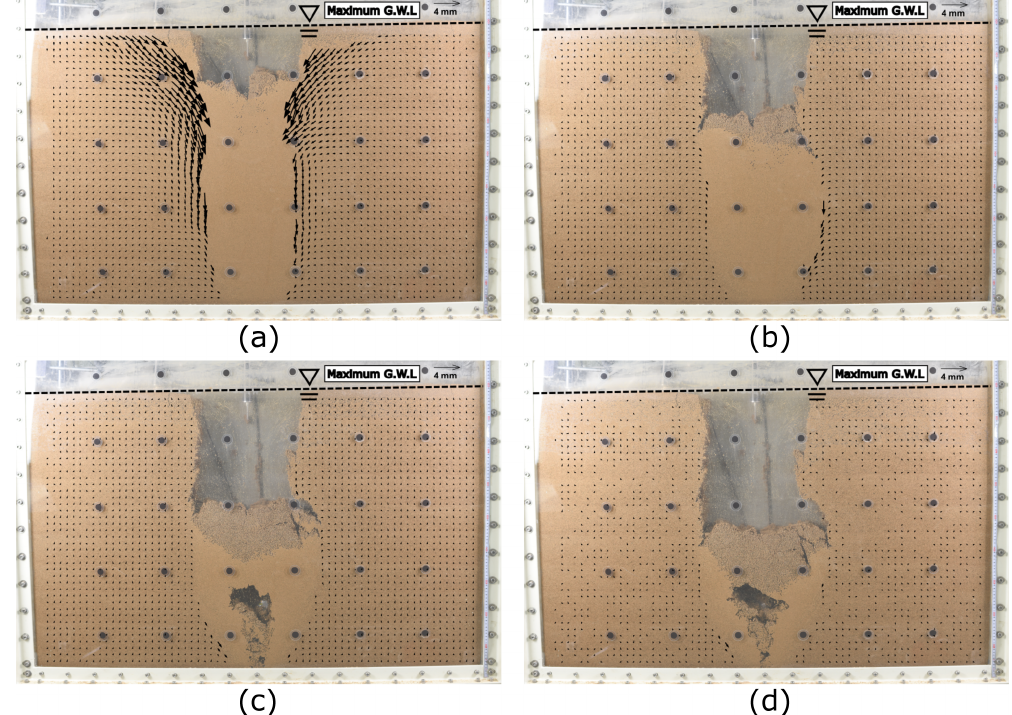
Figure 12. Displacement increment vectors inside the model ground for Test 3 during the water drainage stage: (a) 0–30s, (b) 30–60s, (c) 60–90s, and (d)